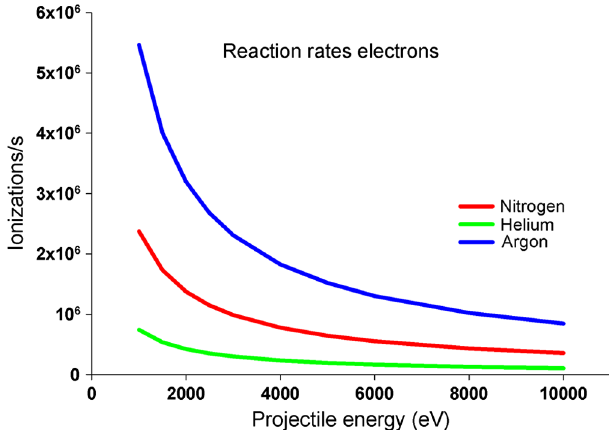
FIG. 8. Calculated reaction rates for electrons